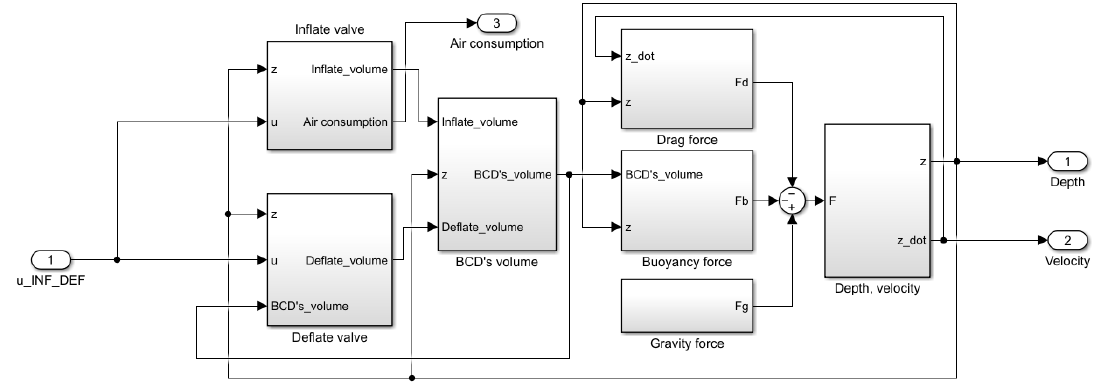
Figure 2. Matlab–Simulink model of a diver’s buoyancy.